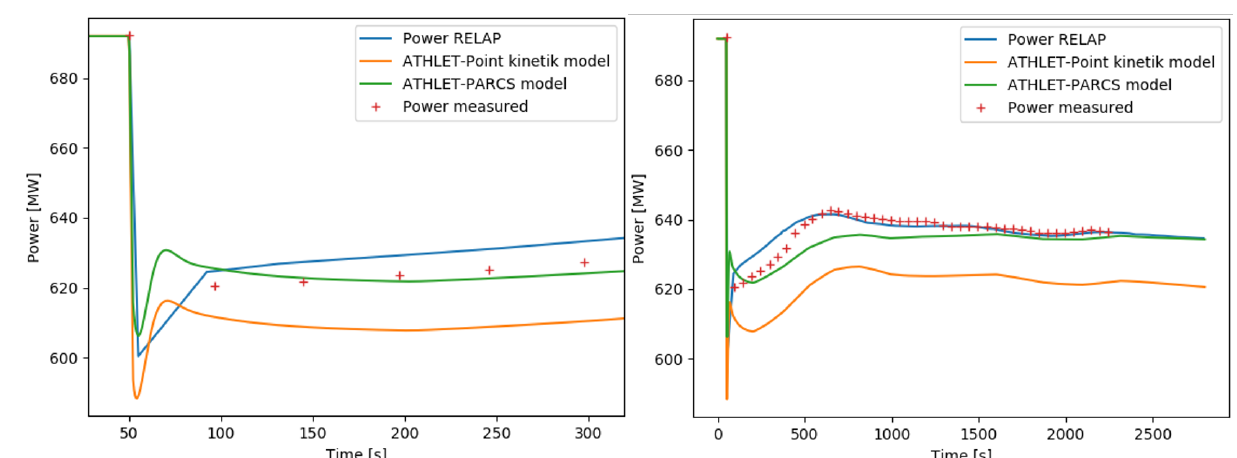
Figure 4: Power calculated by ATHLET-point kinetic, ATHLET-PARCS and by RELAP and measured power during the MOCF1 transient. Values from RELAP and measurements from [13]. Left side: zoom on the beginning of the transient.